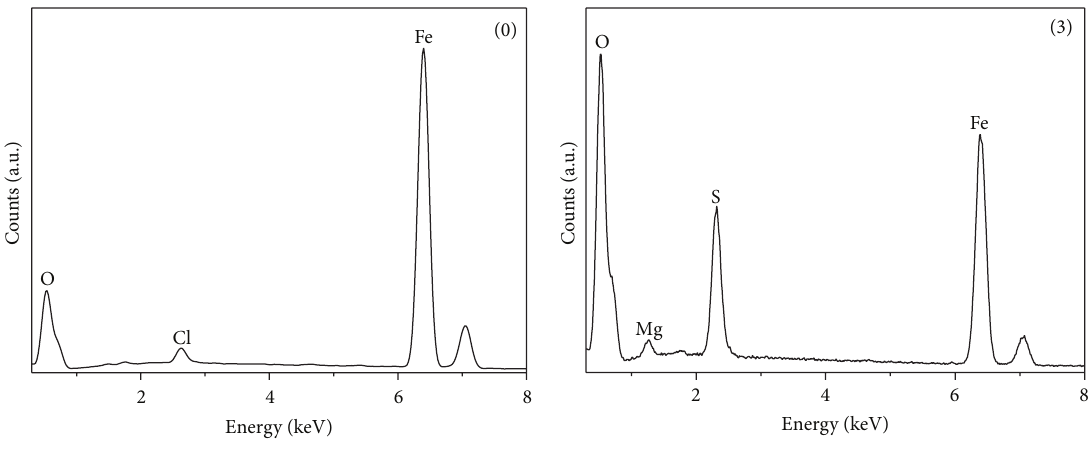
Figure 3: EDS spectra for samples ( 0 ) and ( 3